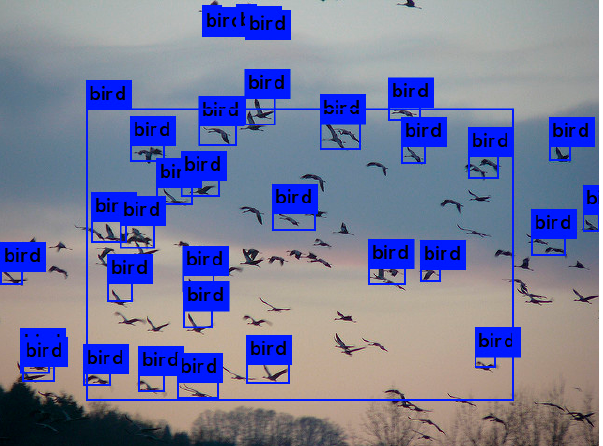
Figure 2. An example of YOLOv3 (You Only Look Once) objection detection result.